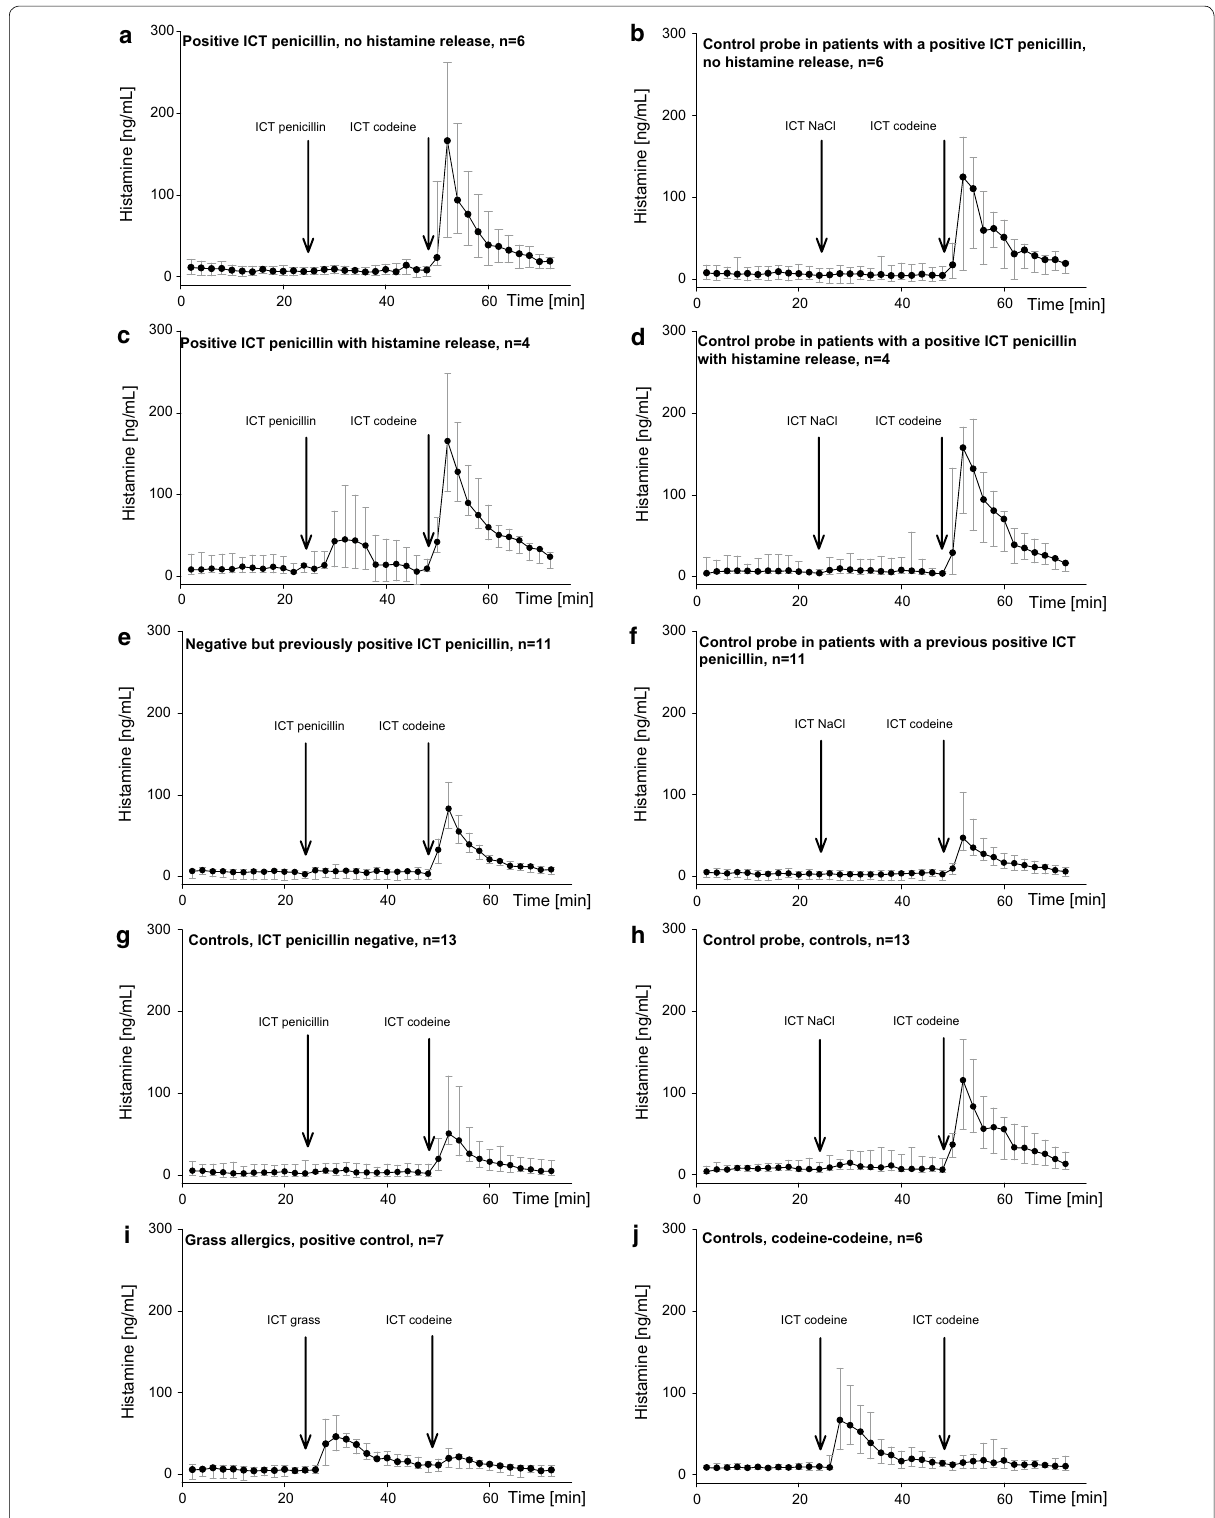
Fig. 2 Time course of histamine release at baseline and after intracutaneous test. A 6‑microliter sample of dialysate was sampled from each probe every 2 min. Results are displayed as medians and 25th and 75th